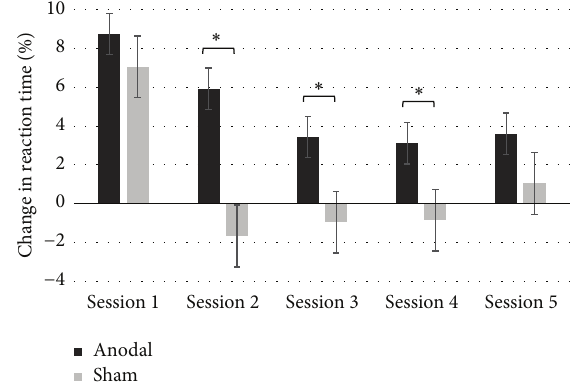
Figure 3: Mean sequence-specific learning (percent change in RT) per group and per session.